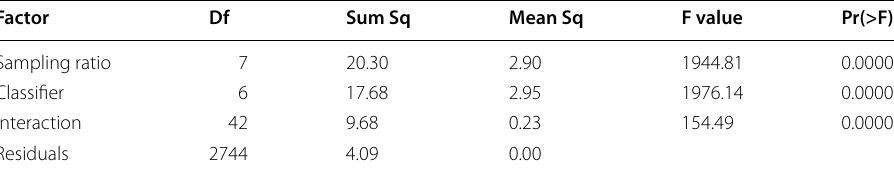
Table 15 ANOVA results for 2-factor test of classifier and sampling ratio with XSS web attacks, including their interaction; in terms of AUC Factor Df